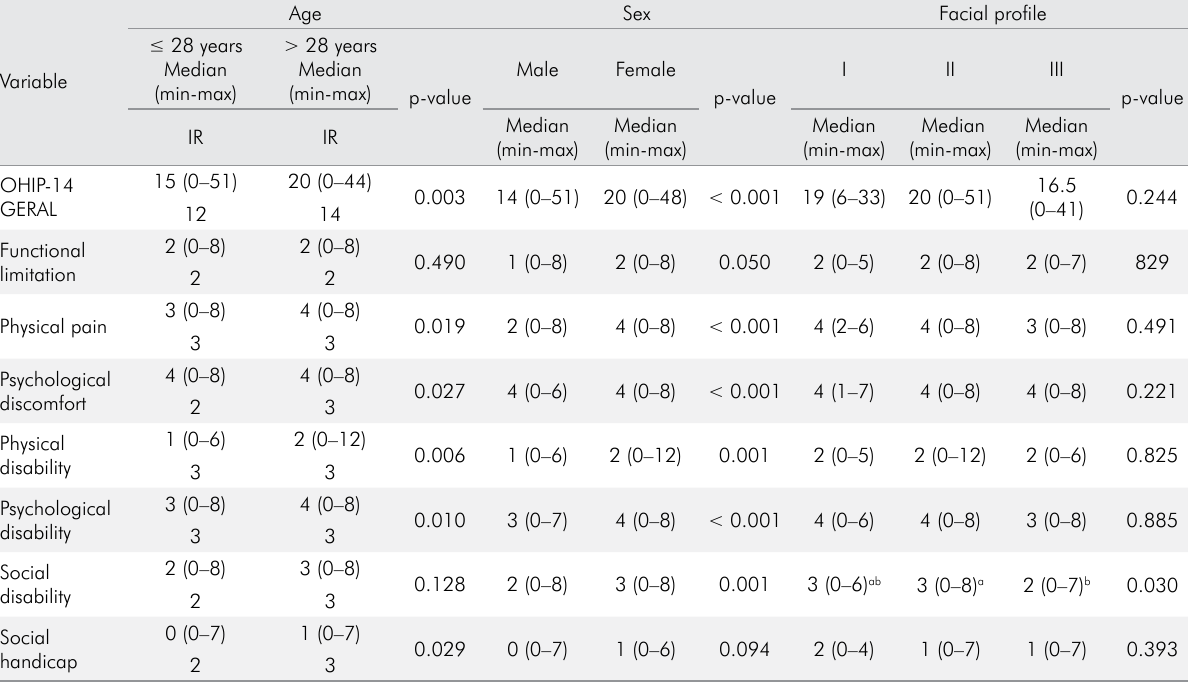
Table 2. Associations of the oral health impact profile 14 (OHIP-14) scores with age, gender, and facial profile in patients with dentofacial deformity